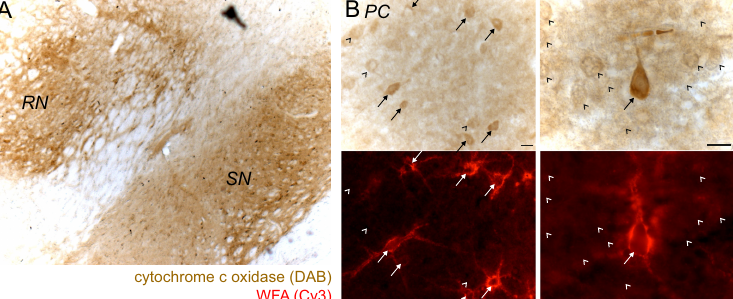
Figure 9. Cytochrome c oxidase enzyme histochemical staining. ( A ) The PN-rich regions red nucleus (RN) and substantia nigra (SN) show increased reaction (DAB-enhanced) for cytochrome c oxidase (CytOx), which is a marker for a high metabolic rate. ( B ) CytOx activity in the parietal cortex (PC). The strongest CytOx reaction is found in PN + neurons (arrows). PN – neurons (arrow head) have a weaker CytOx reaction. Scale bar: